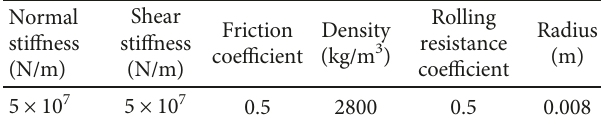
Table 4: Mesomechanical parameters of the waste